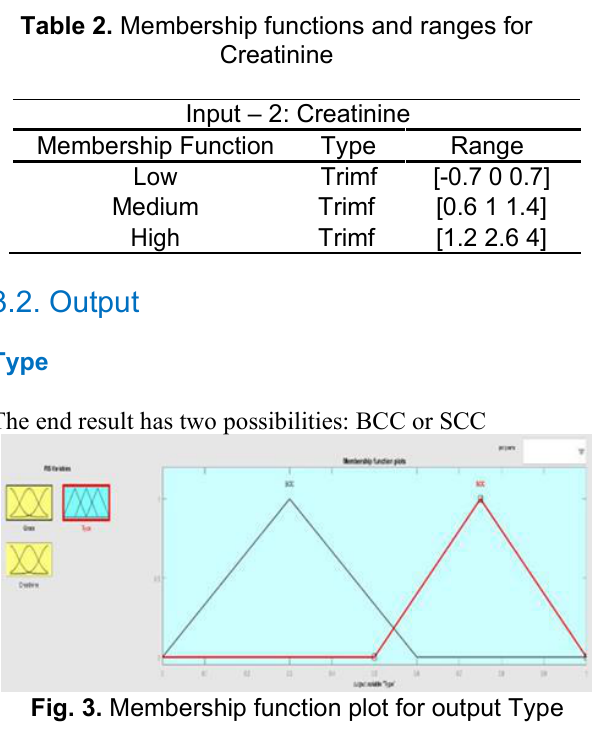
Fig. 2. The fuzzy logic system’s inputs and